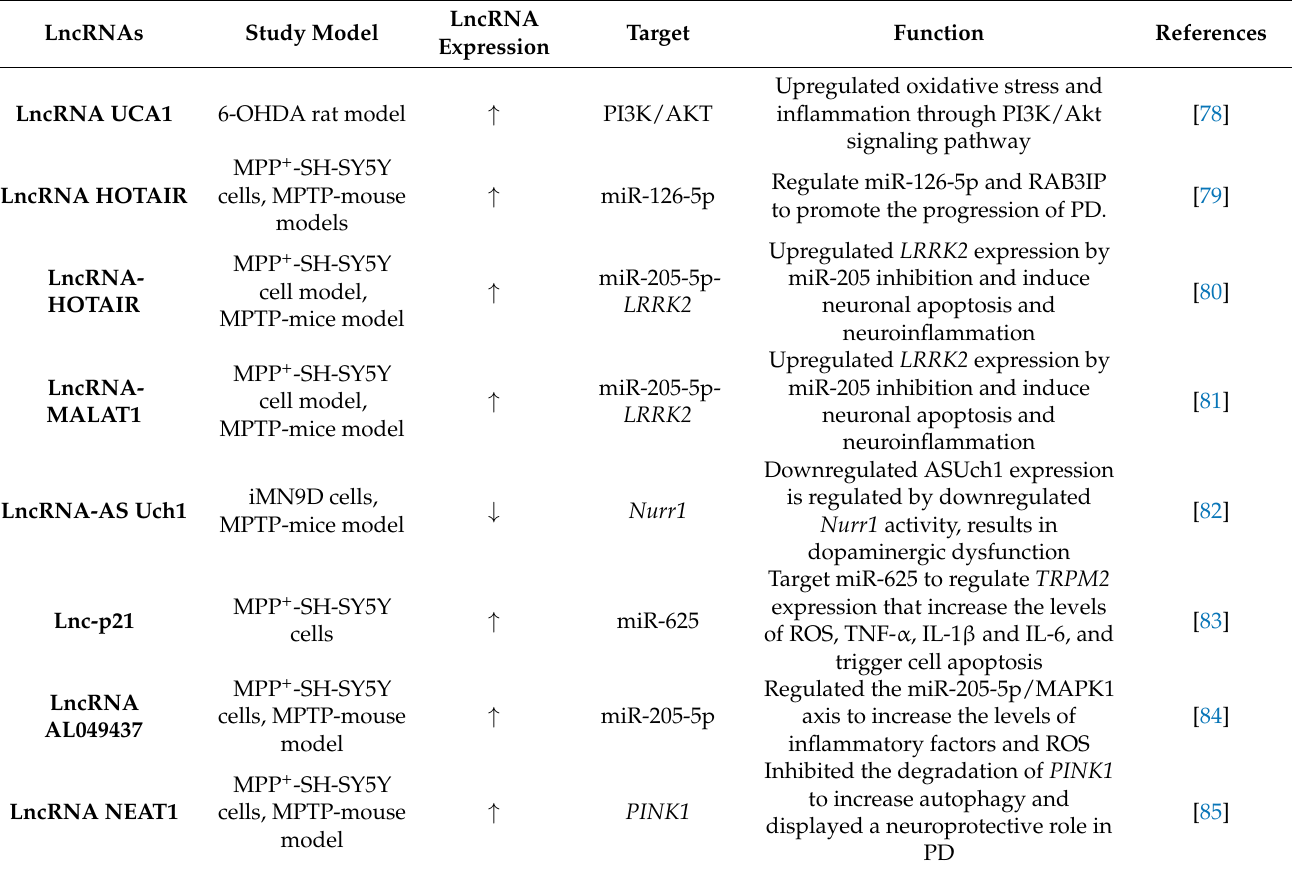
Table 3. Long non-coding RNAs involved in neuroinflammation in Parkinson’s disease. ↑ shows up-regulated, ↓ shows